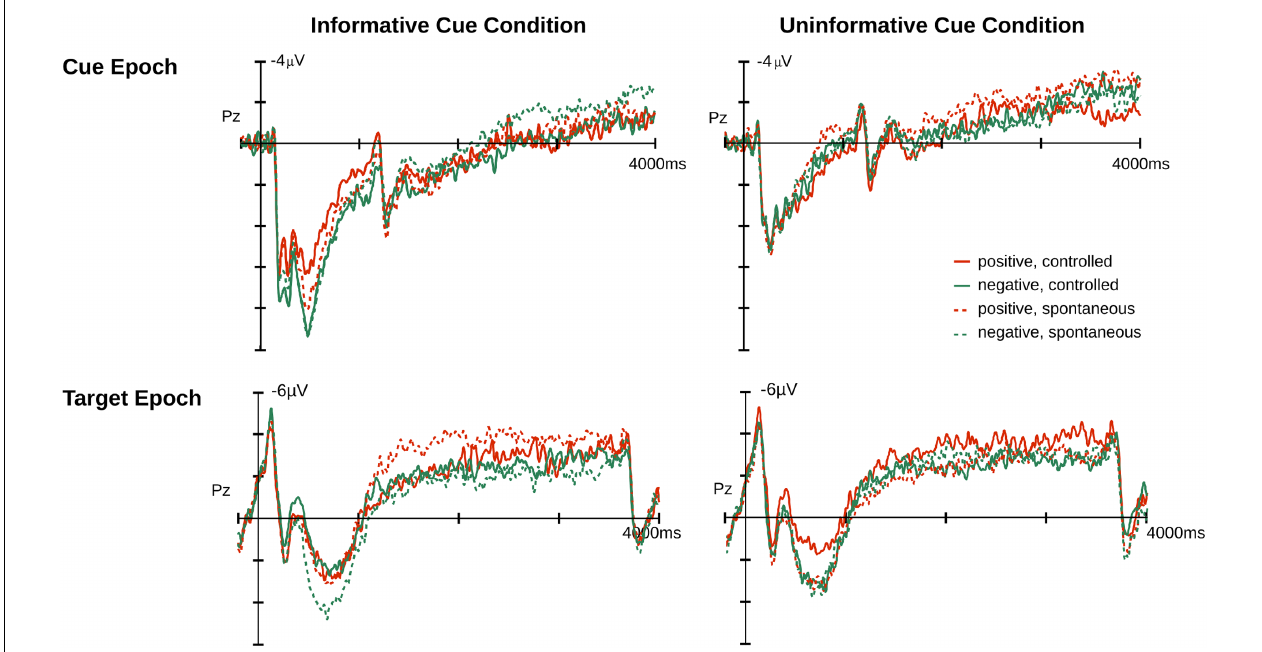
FIGURE 2 | Event-related potential (ERP) average at Pz for cue and target epochs. Illustrated on the left is the ERP time course for the informative cue condition (affective cueing) and on the right for the uninformative cue condition.